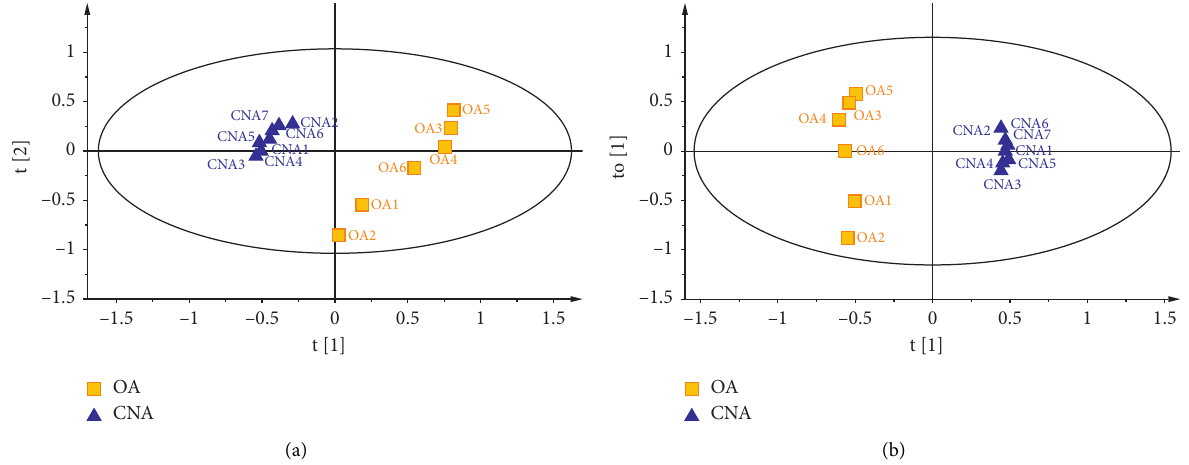
Figure 4: PCA (a) and OPLS-DA (b) scores plot for the first two components of Chi-Nan agarwood (filled triangle) and ordinary agarwood (filled square) data analyzed by